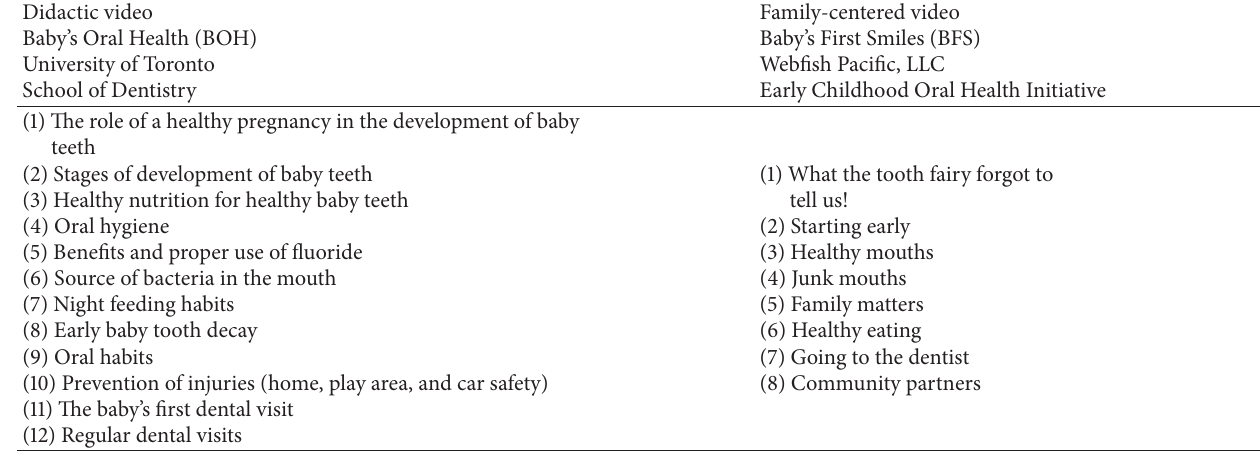
Table 2: Topical organization of video